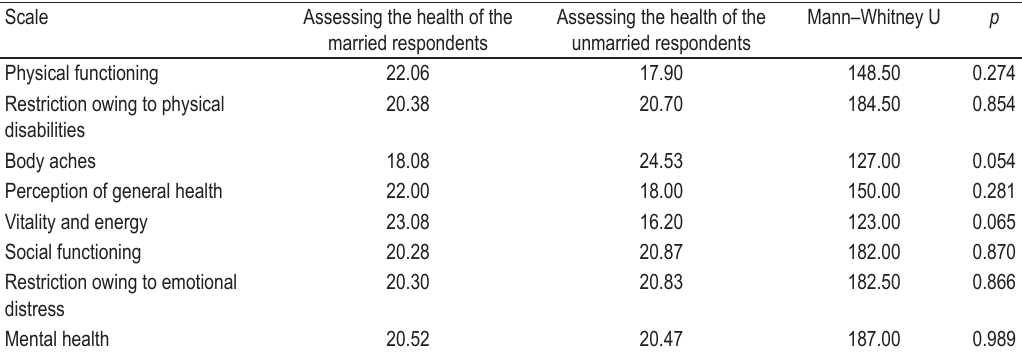
TABLE 5. Assessing health according to marital status (Mann–Whitney U